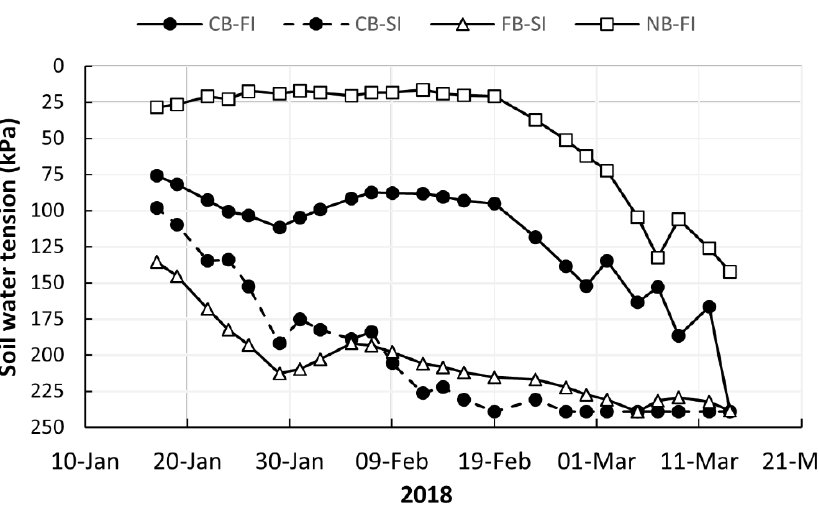
Figure 10. Average soil water tension for each combination of bed architecture and irrigation method tested in the 2017/18 dry growing season: (CB-FI) conventional bed/furrow system with furrow irrigation, (FB-SI) flat bed with sprinkler irrigation, (CB-SI) conventional bed/furrow with sprinkler irrigation and (NB-FI) narrow beds with furrow irrigation.